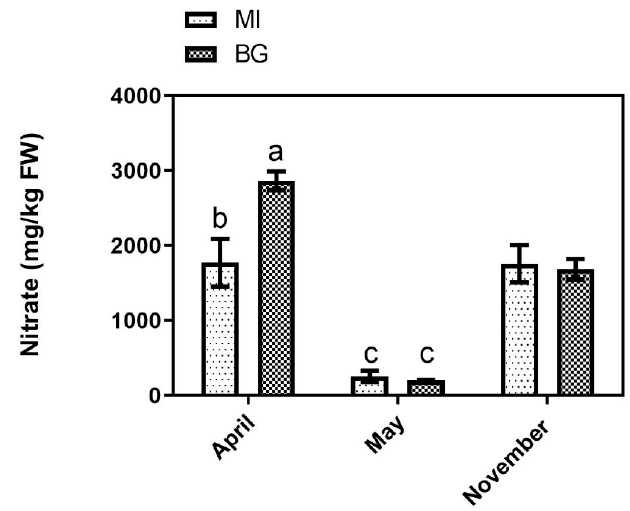
Figure 2. Nitrate content in leaves of two hedge mustard wild populations, BG and MI. Data are means with standard errors ( n = 3 for April and May, n = 4 for November). Data of cycle I were subjected to two-way ANOVA and differences among wild populations and dates within cycles were determined using Tukey’s test. Data of cycle II were analysed using a t -test ( P < 0.05). Different letters indicate statistical differences for P < 0.05. Population means did not differ in November.